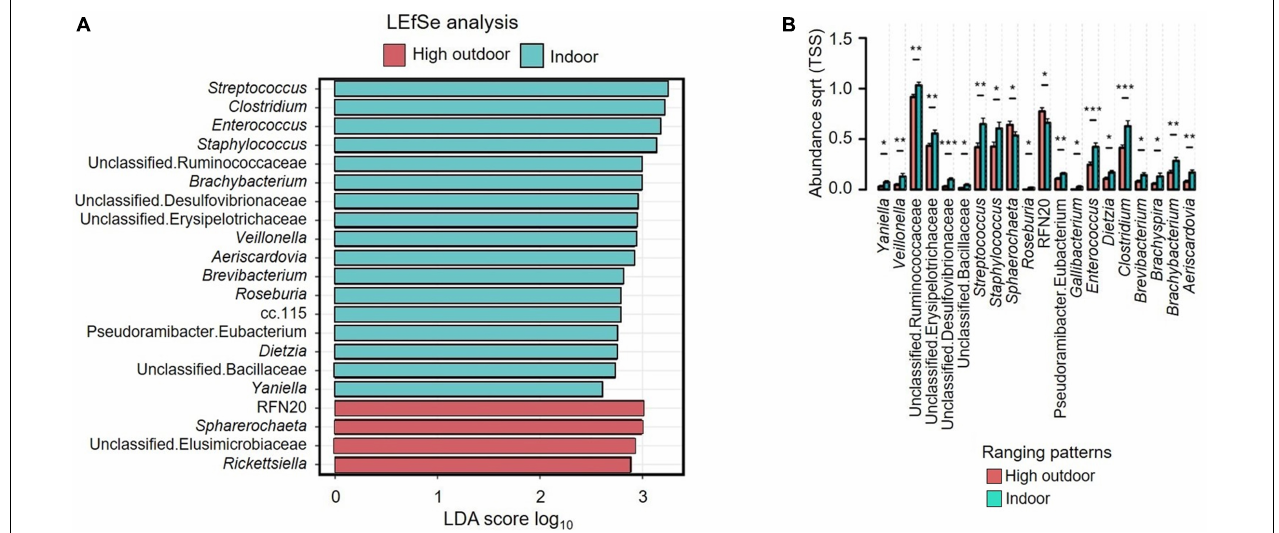
FIGURE 7 | (A) Relative abundance of cecal microbiota of free-range hens at 65 weeks of age from different ranging patterns (high outdoor, indoor) showing linear discriminant analysis (LDA) effect size method (LEfSe). The most abundant genera of microbiota from different ranging groups are shown. (B) Relative abundance of cecal microbiota of free-range hens at 65 weeks of age from different ranging patterns (high outdoor, indoor) at genus level. One-way ANOVA followed by post hoc comparisons between ranging patterns showed differences * P ≤ 0.05, ** P ≤ 0.01, *** P ≤ 0.001.